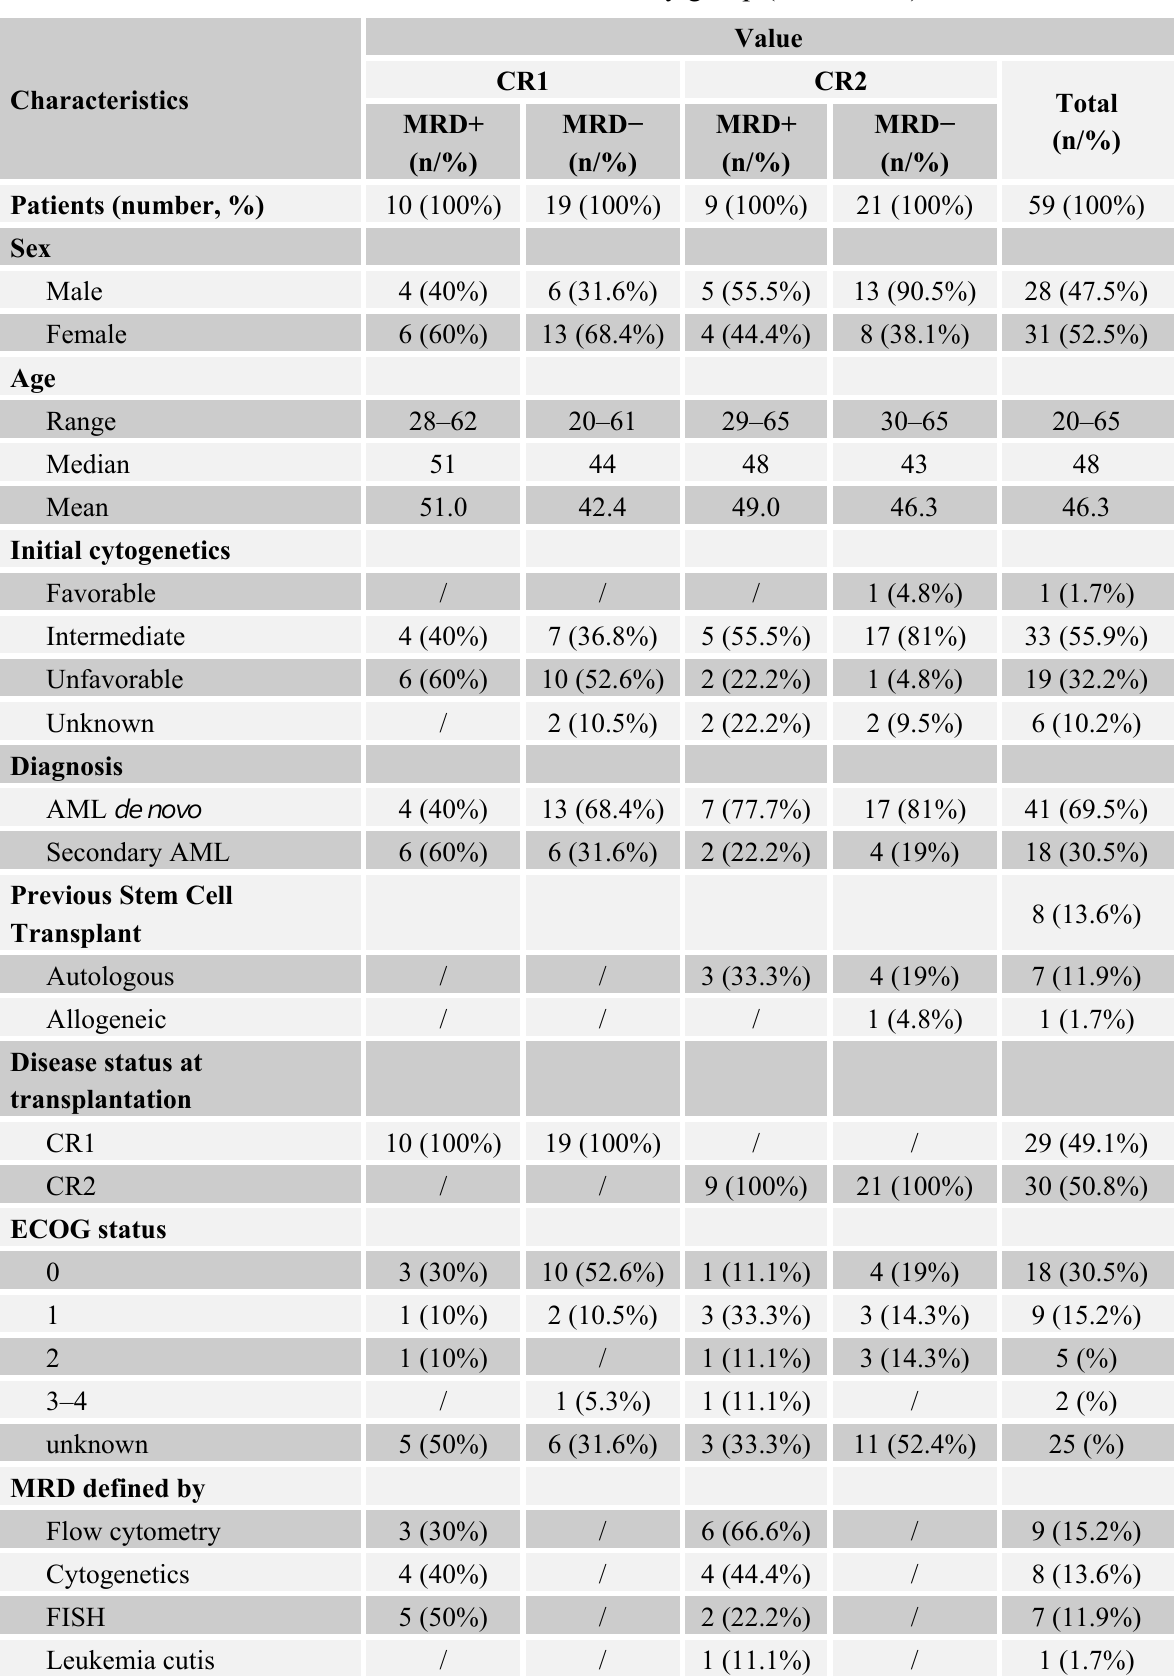
Table 1. Characteristics of the study group